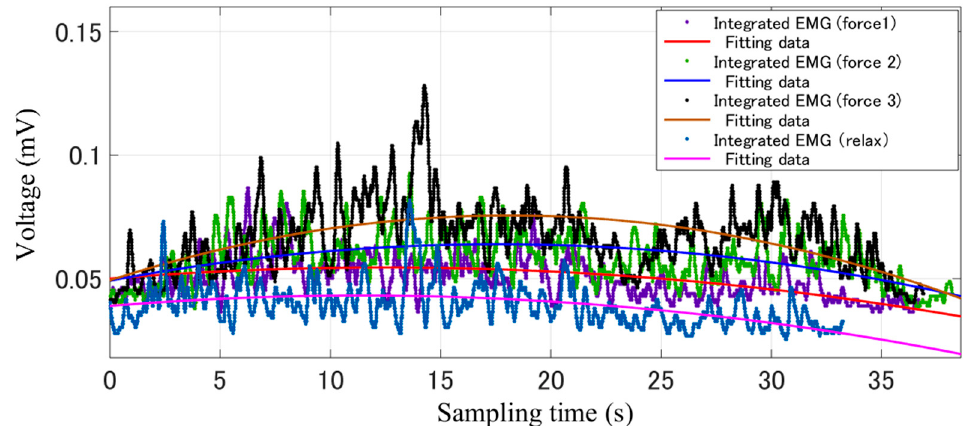
Figure 10. Integrated EMG signals and fitting data.